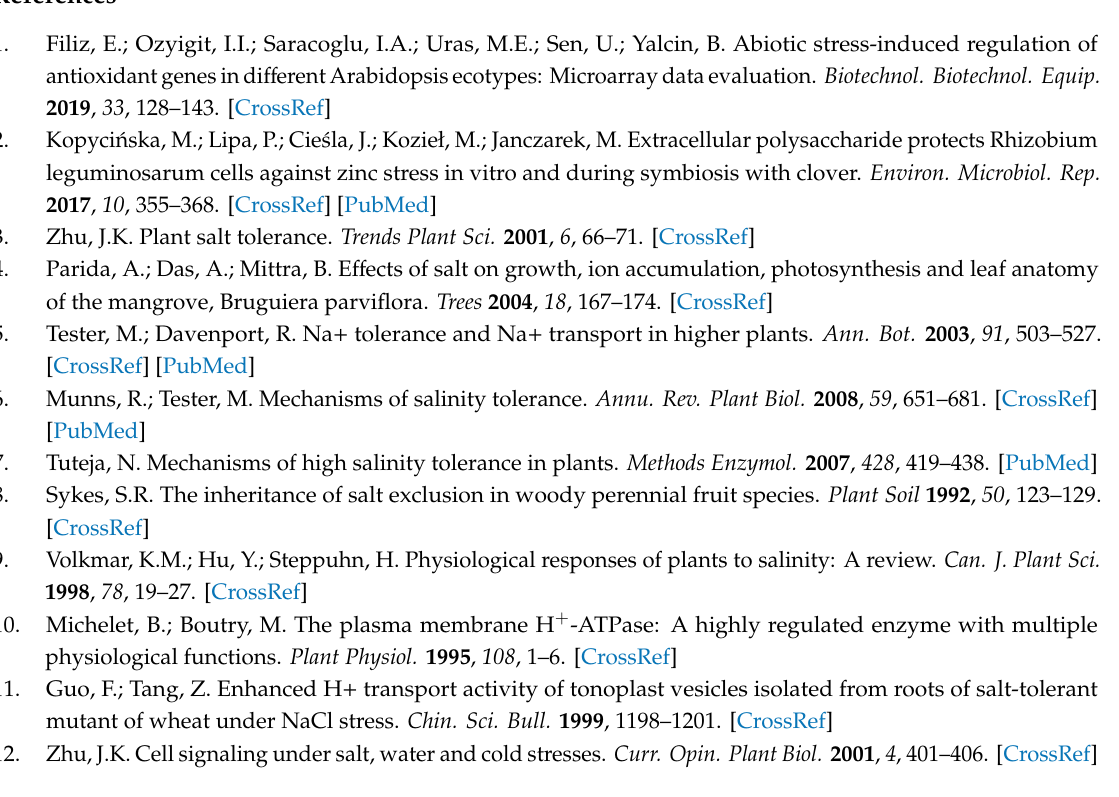
Table S1. Details regarding G. hirsutum NHX genes. Table S2. Protein, coding and genomic sequences of G. hirsutum NHX genes. Table S3. Details regarding G. raimondii and G. arboreum NHX genes. Table S4. Protein sequences of G. raimondii and G. arboreum NHX genes. Table S5. Protein sequences of NHX genes from A. thaliana, P.